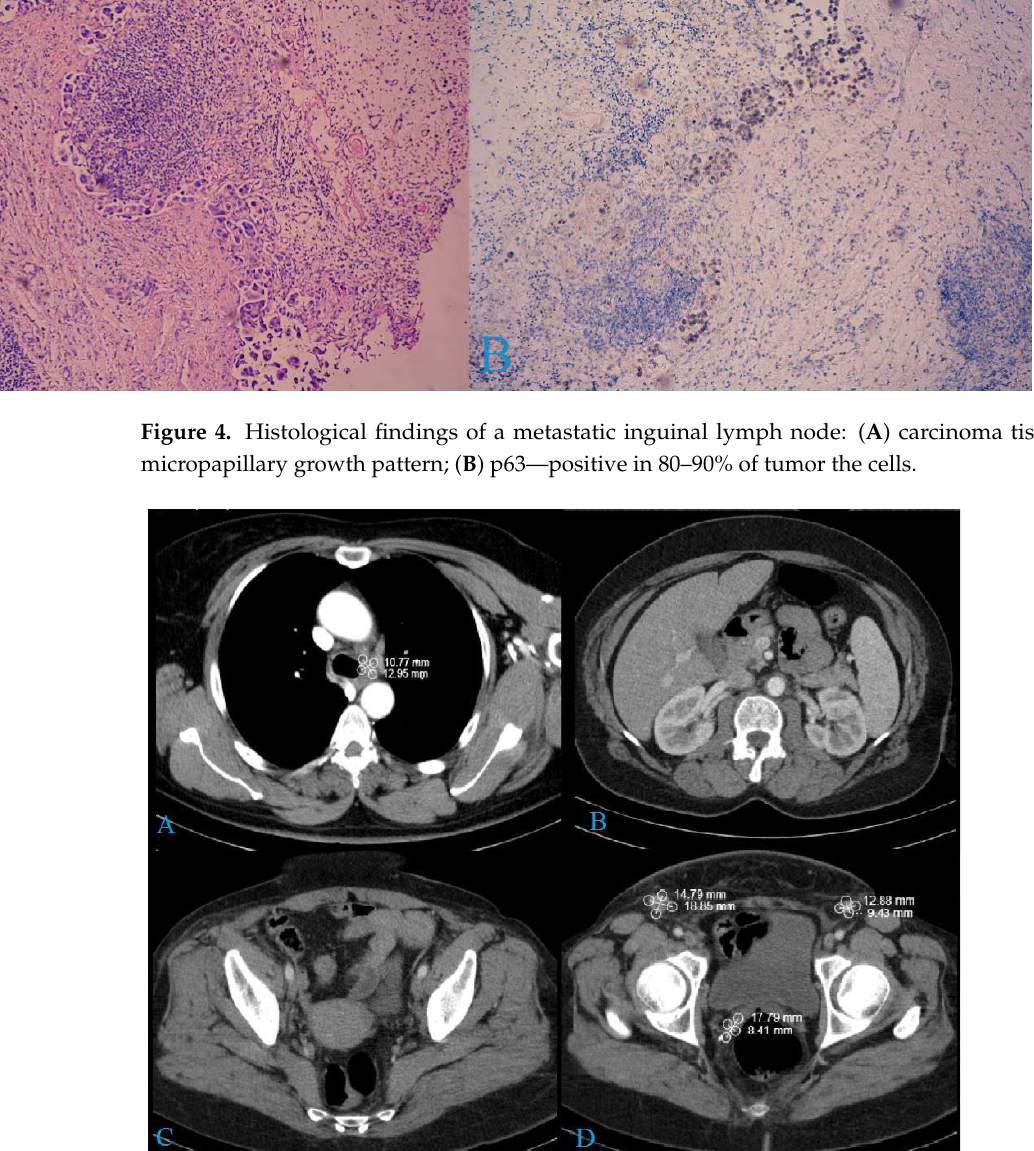
Figure 5. Restaged CT findings: ( A ) 30% decrease in the pathologically enlarged paratracheal lymph nodes; ( B ) the para aortic lymph nodes are not visible (all with normal size); ( C ) the common iliac lymph nodes are also not visible; ( D ) soft tissue lesion in the cervix and the inguinal lymph nodes again present size reduction of over 30%.